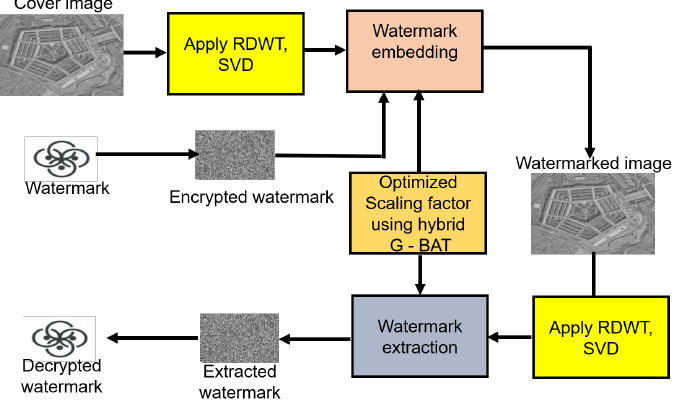
Figure 1. Flowchart of the proposed